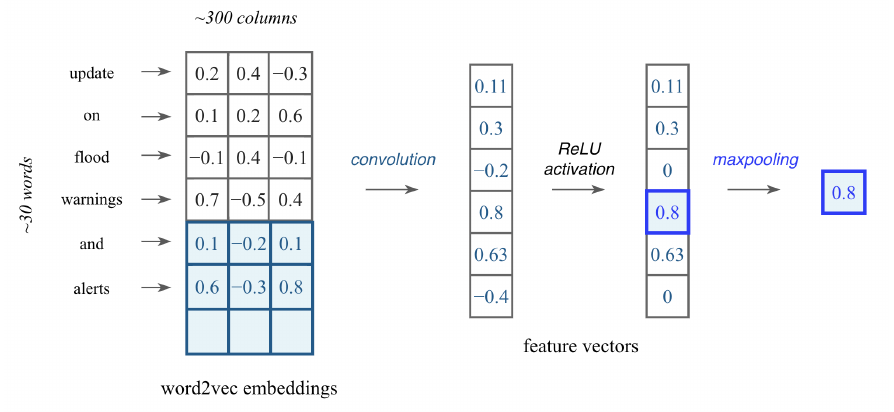
Figure 3. Example of 1D convolution applied to word embeddings producing a feature vector through using a ReLU function and a max pooling layer.